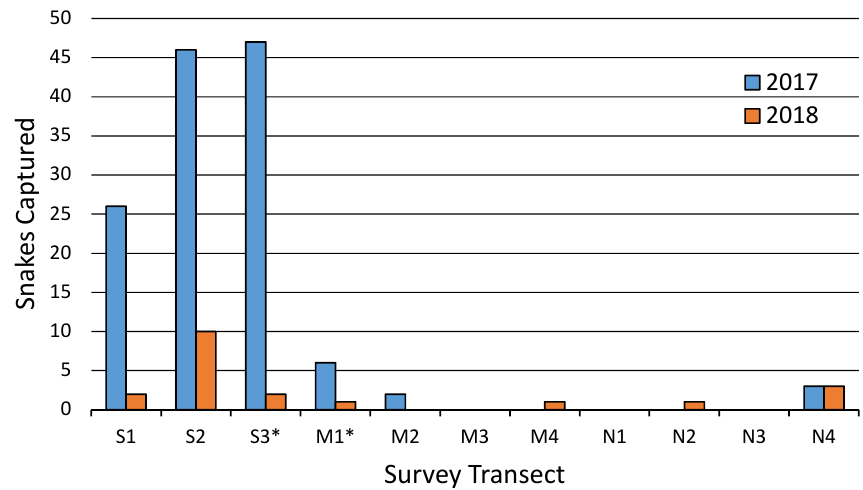
Figure 2. Clonophis kirtlandii captures between coverboard transects. More snakes were captured in